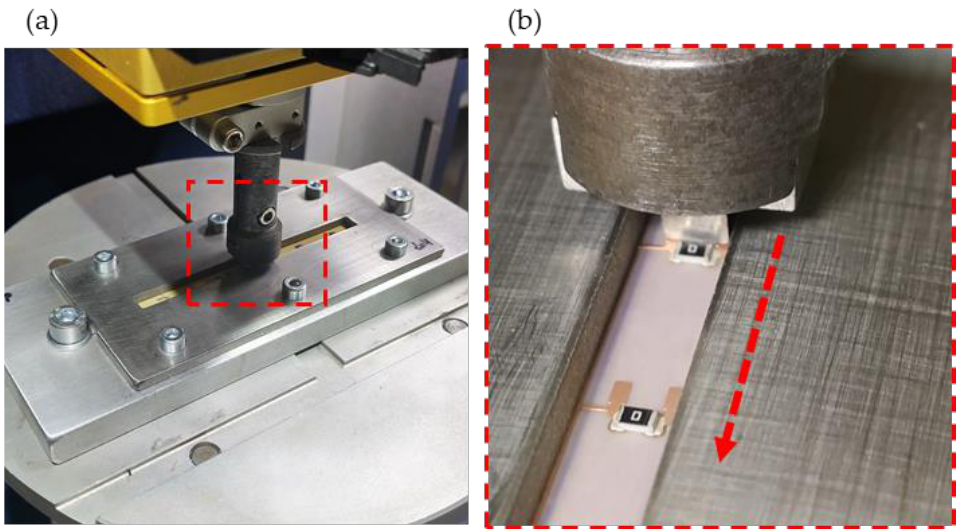
Figure 6. The foils were fixed within a clamping plate fixture ( a ) and sheared off ( b ).